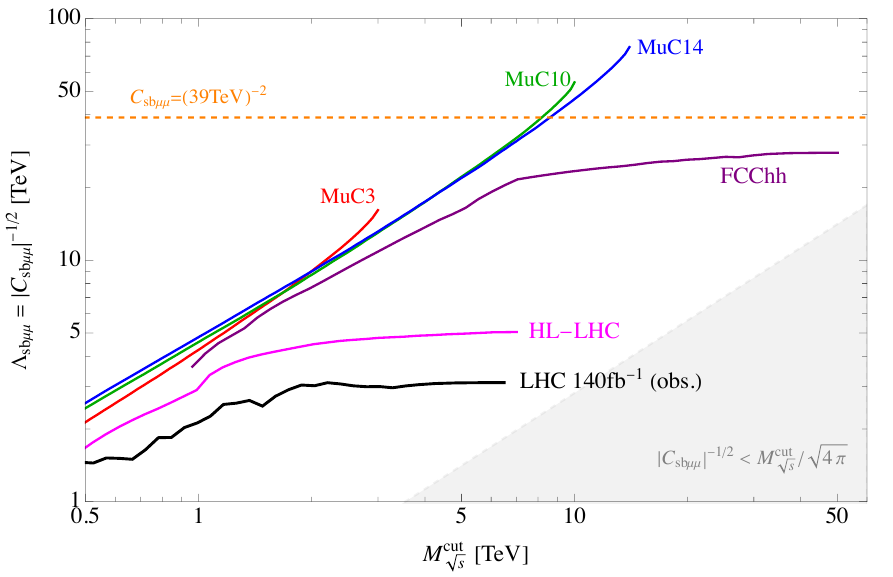
Figure 7 . Sensitivity reach (95%CL) for the (¯ s L γ α b L )(¯ µ L γ α µ L ) contact interaction as function of the upper cut on the final-state invariant mass, compared to the value required to fit bsµµ anomalies (dashed orange line).